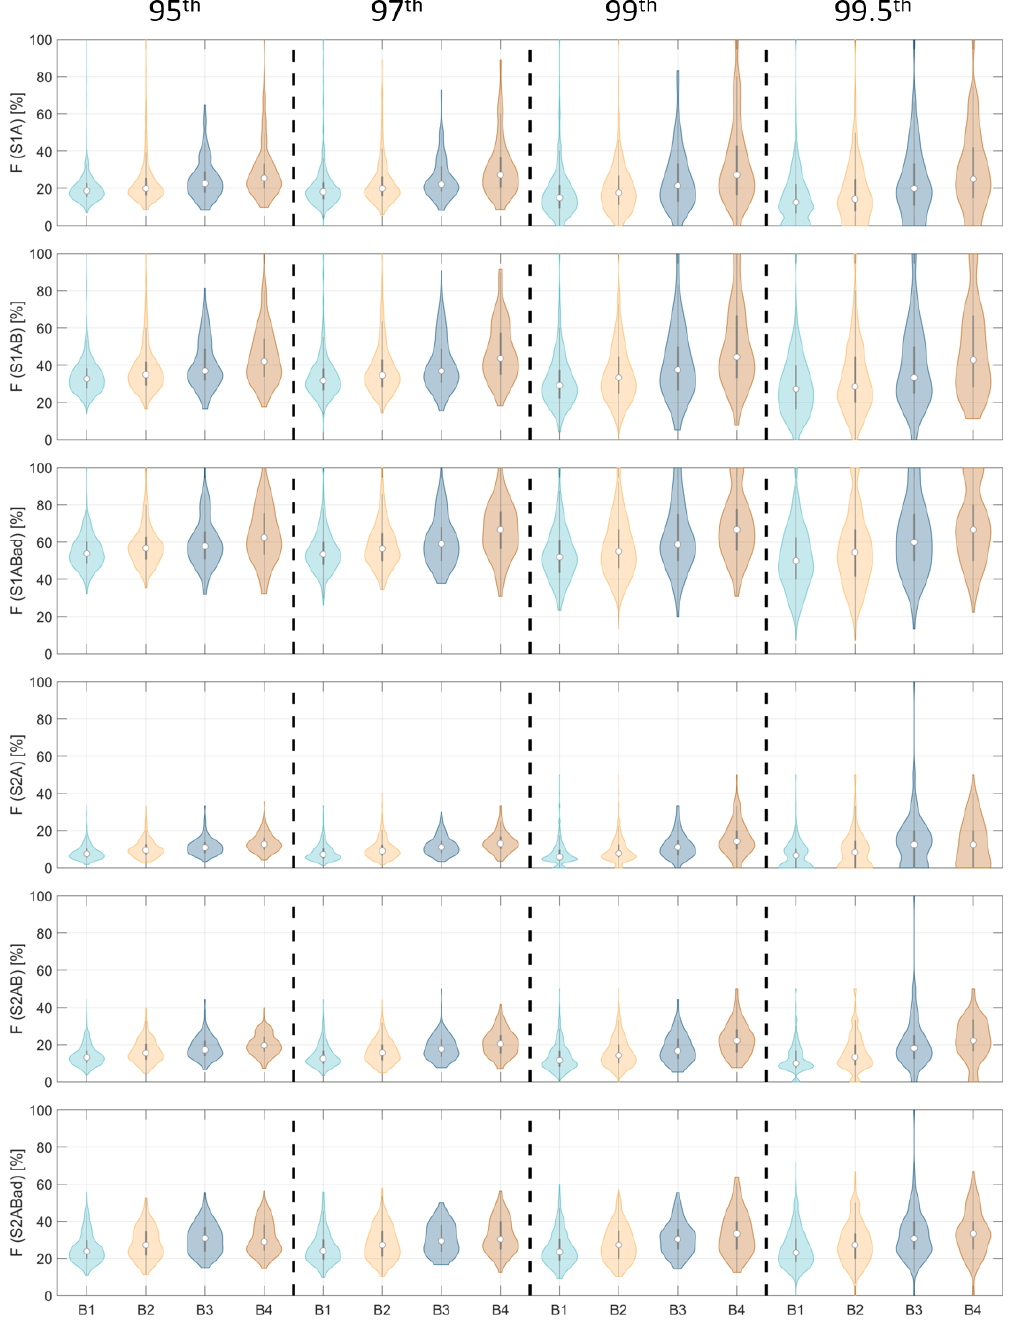
Figure 6. Violin plots of the percentage of events detected by satellite observations with respect to the total events observed at ground sites. The six scenarios are explained on Table